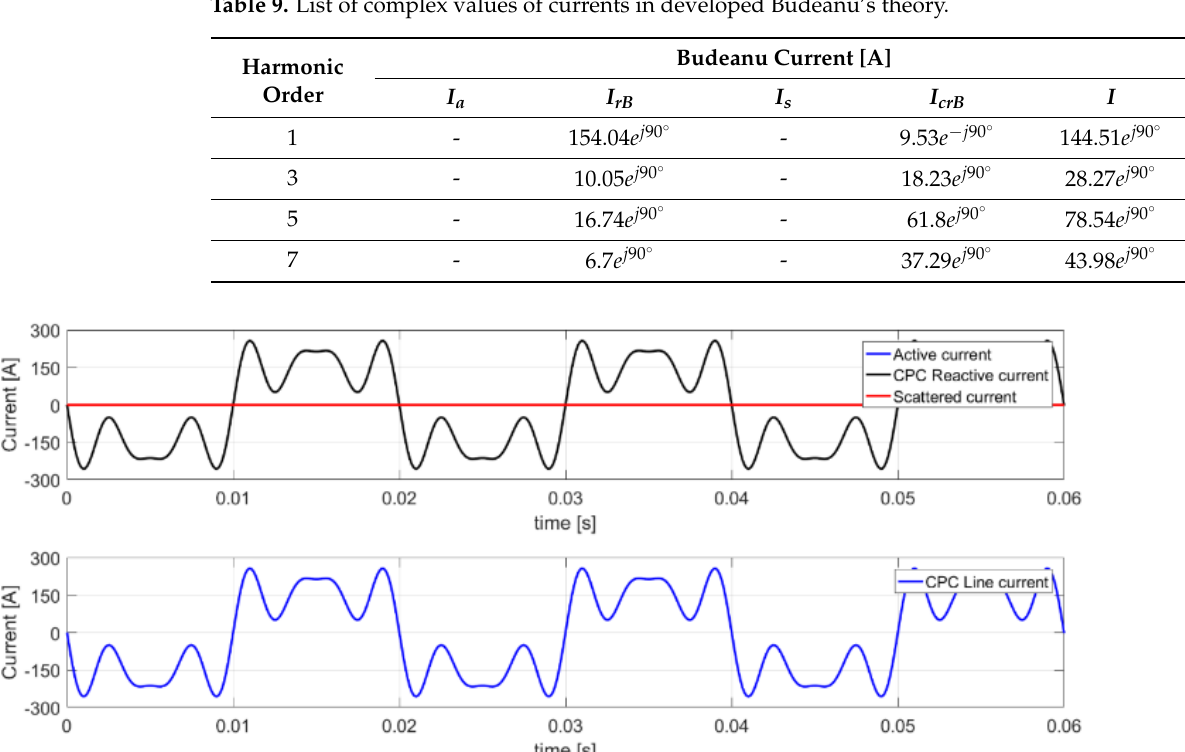
Table 9. List of complex values of currents in developed Budeanu’s theory.